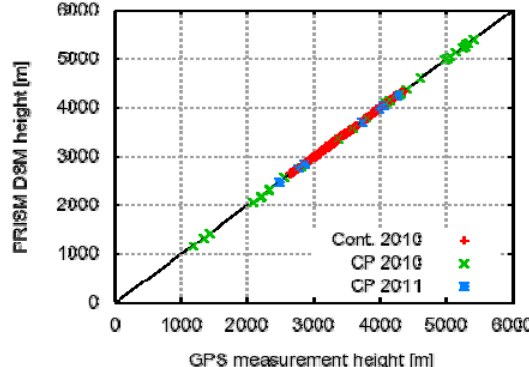
Figure 8. Histogram of height differences between PRISM DSM mosaic and ground-based GPS measurements.